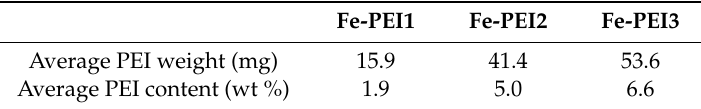
Figure 2. Chemical composition of the surface of ( a ) pure Fe; ( b ) Fe-PEI1; ( c ) Fe-PEI2; and ( d ) Fe-PEI3 samples studied by the energy dispersive X-ray analysis (EDX) method. Table 1. Average weight (mg) and content (wt %) of polyethyleneimine (PEI) coating deposited on the surface of the iron